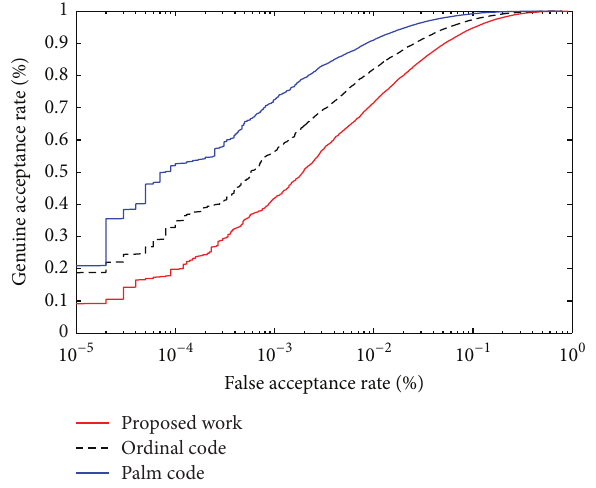
Figure 14: ROC curve using global features of proposed DOST for COEP palmprint